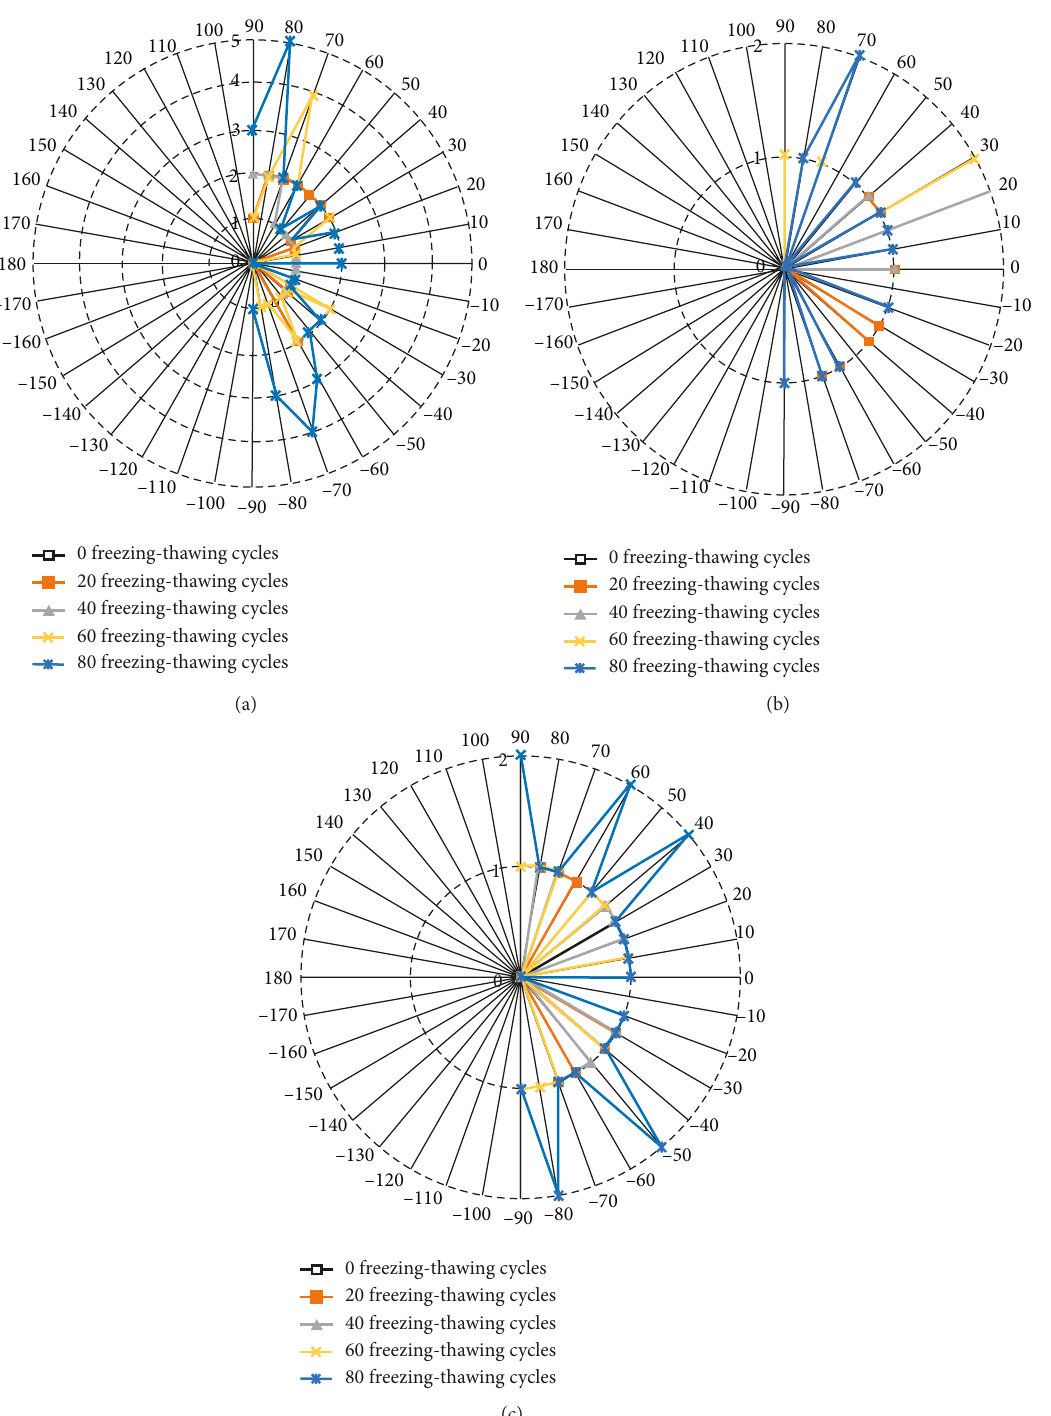
Figure 10: The characteristics of the azimuthal angle in (a) the intercrystalline crack, (b) the transcrystalline crack, and (c) the intra- crystalline crack under freezing-thawing